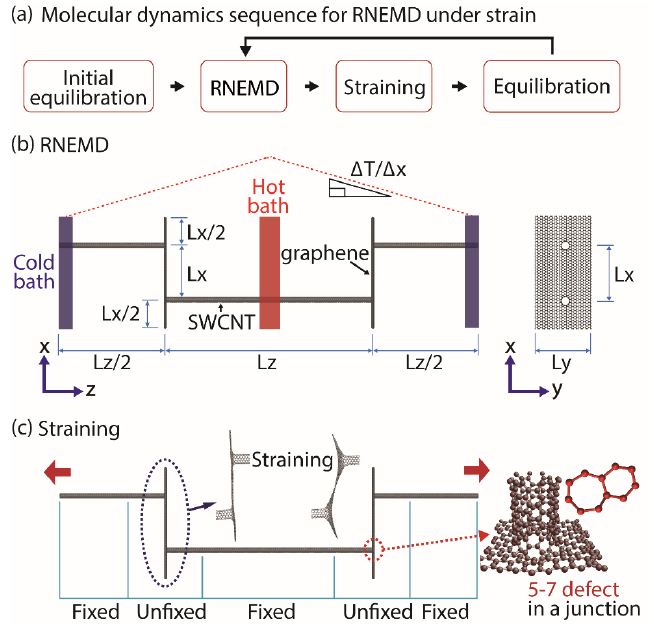
Figure 2. Interfacial thermal resistance estimation for a SWCNT – graphene junction structure under mechanical deformation using